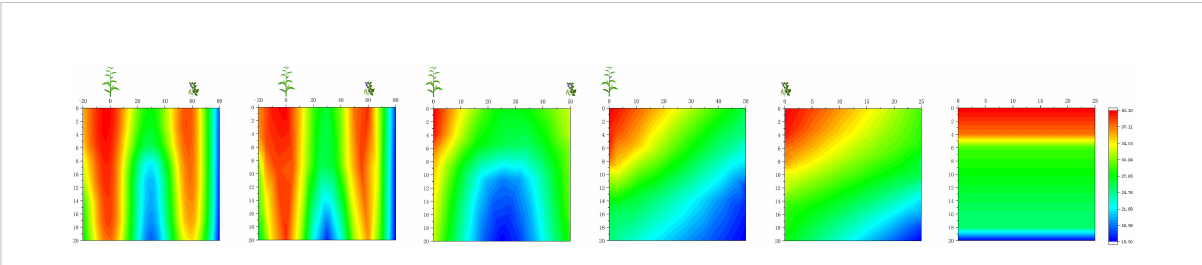
FIGURE 4 Spatial distribution of soil organic matter under different planting patterns of maize and soybean. MS1, MS2, MS3, M, S, and FL represent the continuous planting of maize/soybean relay strip intercropping, planting of maize/soybean relay strip intercropping in rotation, traditional maize/ soybean intercropping, sole maize planting, sole soybean planting, and fallow land, respectively.